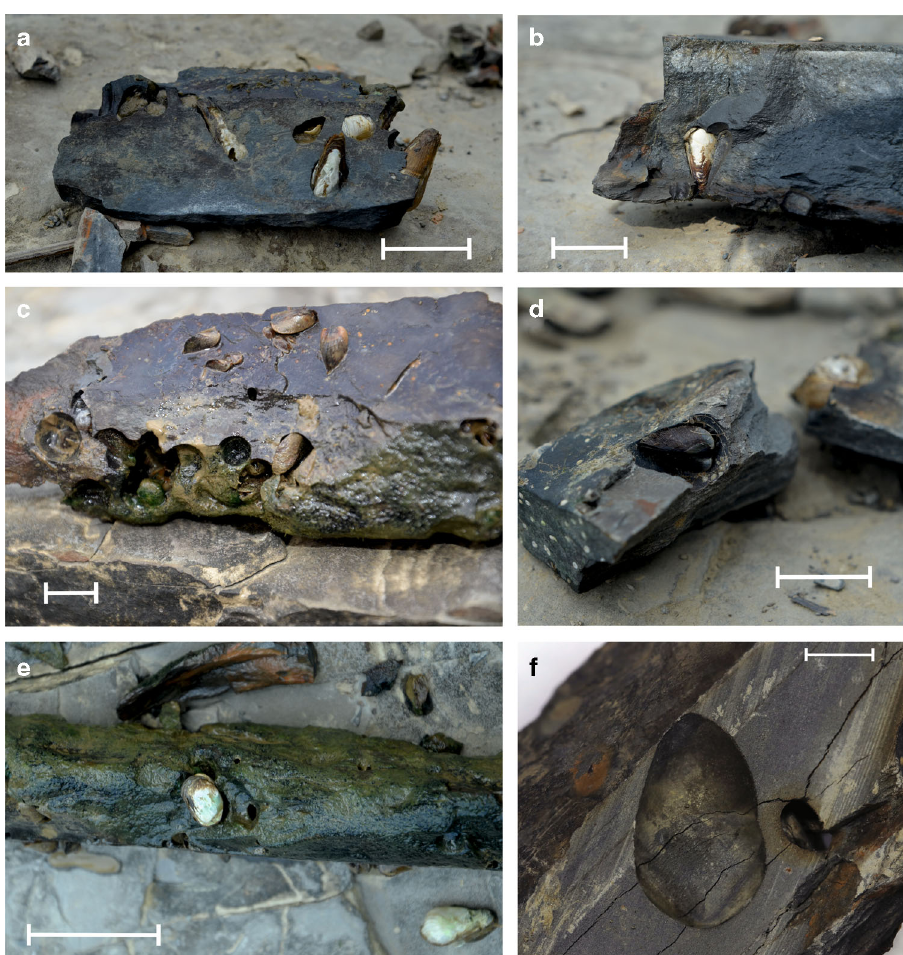
Fig. 3 Blocks of siltstone rocks with borings and living macroinvertebrates from the freshwater bioerosion site at the Kaladan River, Myanmar. a , b Rock- boring mussels, Lignopholas fl uminalis , in their clavate borings (ichnospecies: Gastrochaenolites anauchen ). c Arc clams, Scaphula deltae , and empty borings fi lled with clay, a habitat of polychaetes Neanthes meggitti and Namalycastis indica (Nereididae). d Arc clam, Scaphula deltae , in an empty boring. e Jackknife clam, Novaculina gangetica , and sponge, Corvospongilla ultima . Scale bars = 10 mm (Photos: Olga V. Aksenova). f Longitudinal cross-section of the boring, Gastrochaenolites anauchen . Scale bar = 5 mm. (Photo: Ilya V.